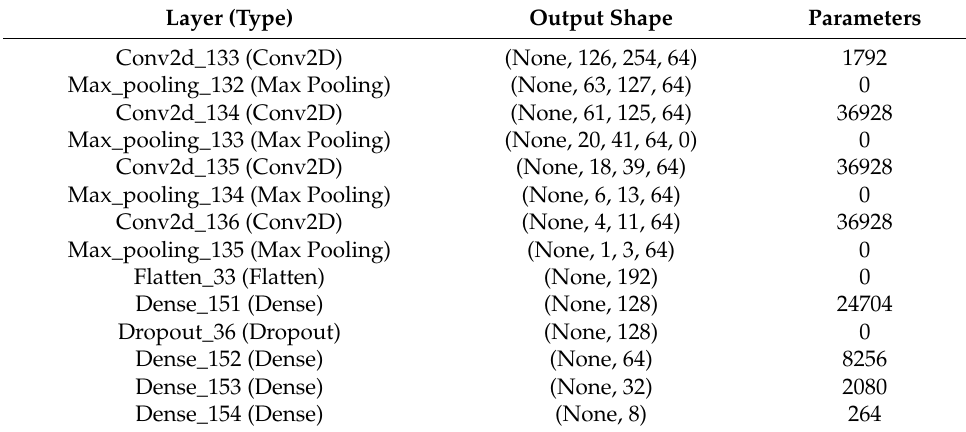
Table 2. Model Summary.